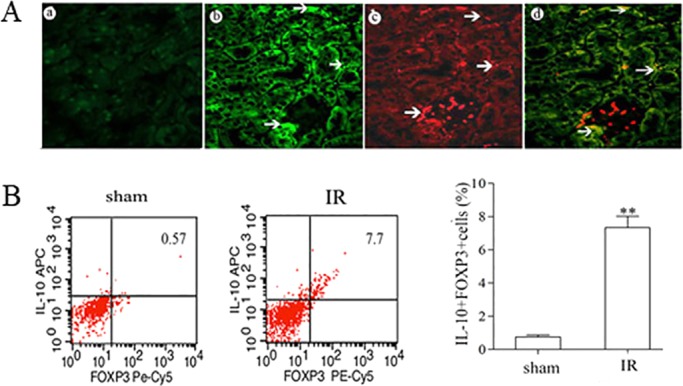
Foxp3+ cells are the source of IL10 in the recovery phase after renal IR injury. C57BL/6 mice underwent IR by unilateral renal pedicle clamping for 45 min, followed by reperfusion. (A) On day 3, the kidneys were harvested for immunofluorescence staining and flow cytometry analysis. Dual immunofluorescence staining for IL10 (b; green, arrows indicate TECs and infiltrated cells) and Foxp3 (c; red, arrows indicate infiltrated cell nuclei), indicating that the majority of IL10-positive cells were Foxp3-positive Treg cells (d). (a) No antibody control. (B) Representative flow cytometry results for Foxp3 and IL10. The percentage of Foxp3- and IL10-positive cells were increased in IR kidneys after 3 days compared with sham-treated kidneys. Data are presented as mean±s.d. (n=6 mice). **P<0.01 versus sham treated.